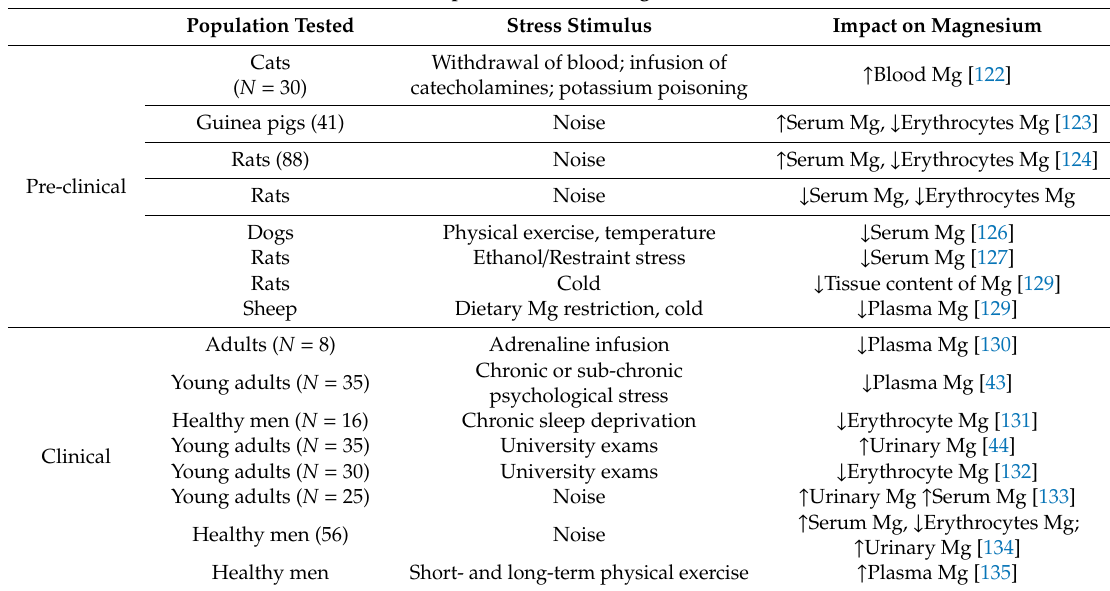
Table 4. Summary of the pre-clinical and clinical evidence supporting the impact of stress on magnesium